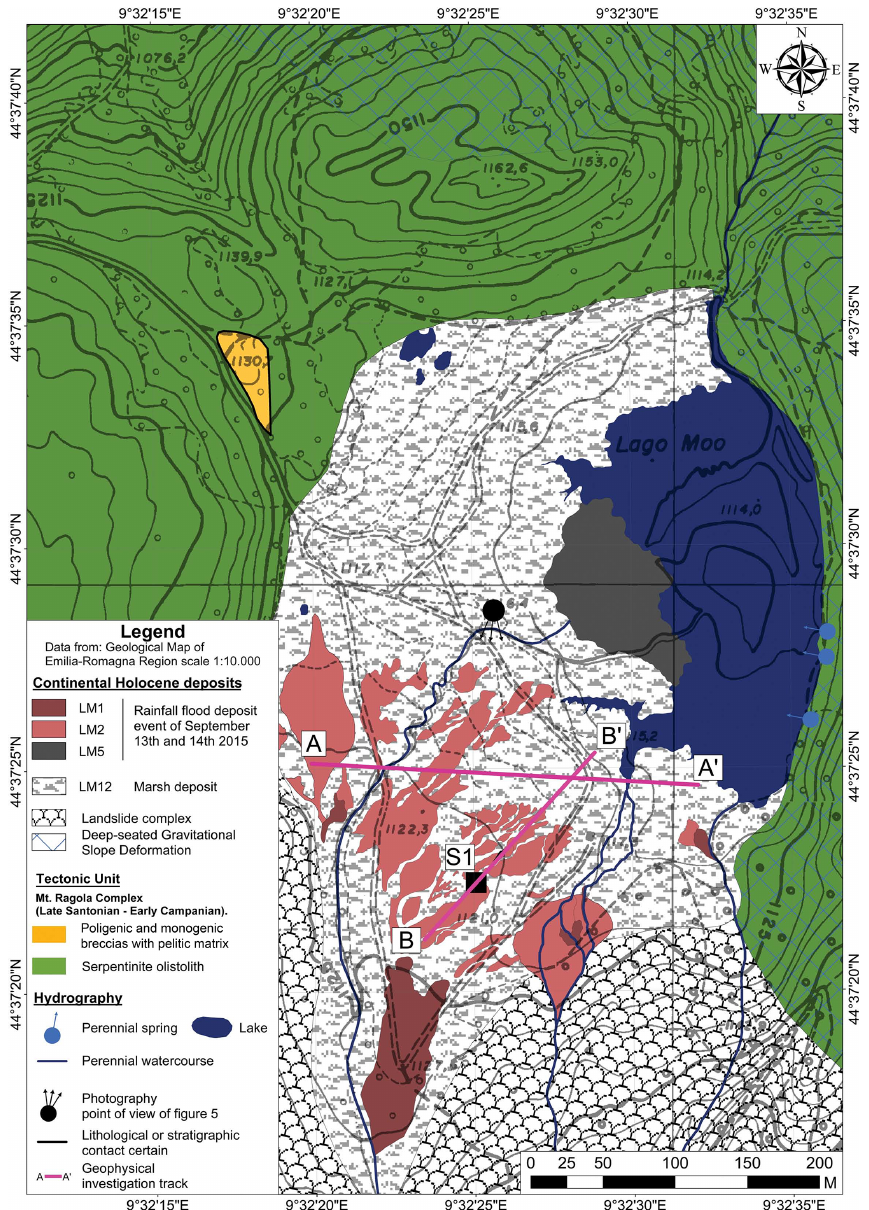
Figure 2. Geomorphological map showing the main geological units and the hydrological elements of the Lake Moo plain. The detailed mapping of flood deposits formed during the recent HIP event (13–14 September 2015), the location of the geognostic investigations and the geophysical survey tracks are also reported. Original data from the field campaign are overlaid on the geological database of the Emilia– Romagna